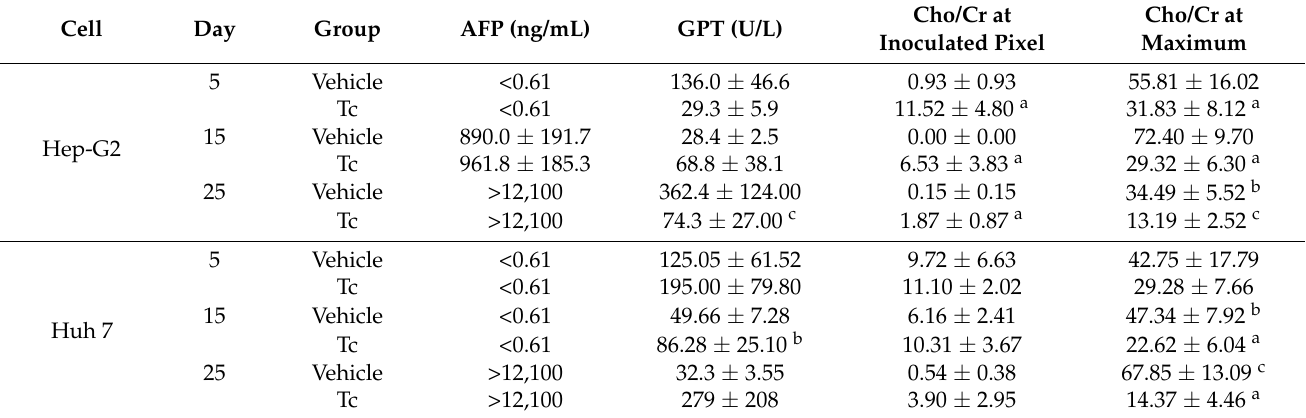
Table 3. Effects of tagitinin C on alpha-fetoprotein (AFP) and glutamate pyruvate transaminase (GPT) and choline/creatine ratio according to chemical shift imaging of two hepatocellular carcinoma xenograft lines. Representative AFP and GPT values from tagitinin C (15 µ g/mouse/day)-treated and vehicle (0.075% DMSO)-treated groups. The Cho/Cr ratio at maximum represents the reading for the pixel with the maximum ratio on the whole slice. All mice were euthanized after the MR assay. a p < 0.05 when compared to vehicles in the same group. b p < 0.05 compared with experimental values after treatment for 25 days. c p < 0.05 when compared to the vehicle after 15 days of treatment. Differences between groups were compared using the Student’s t -test. Tc: tagitinin C; Cho/Cr: